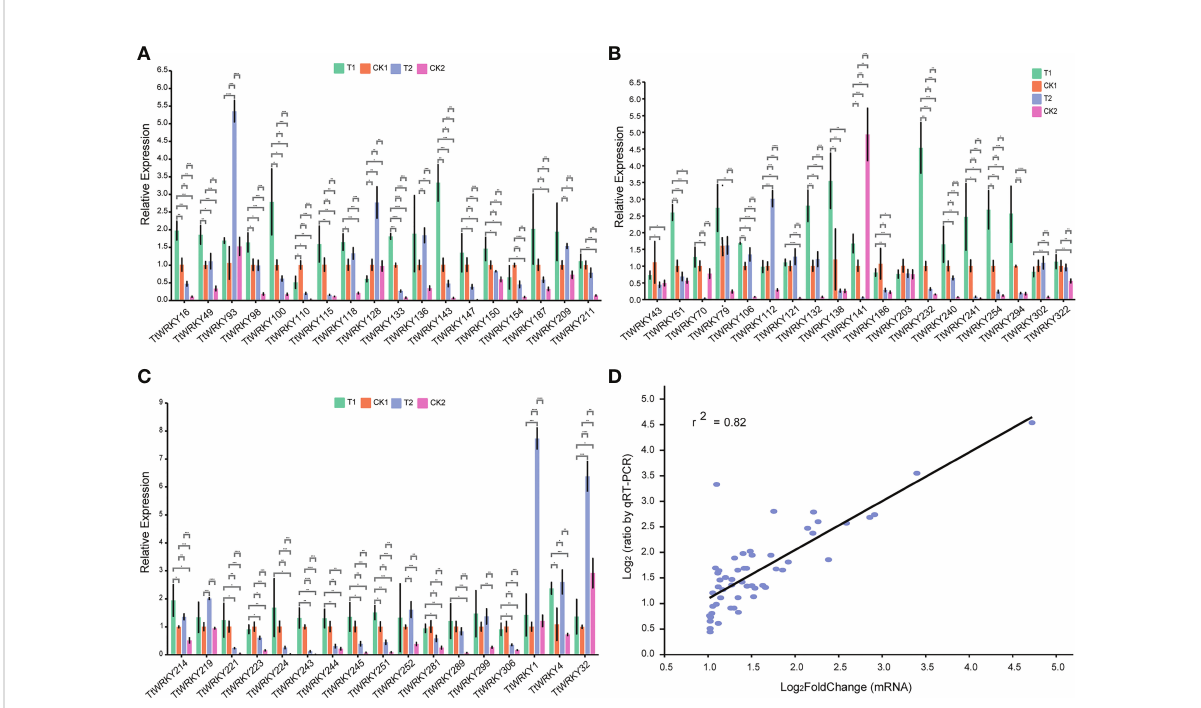
FIGURE 6 (A – C) Expression analysis of 54 WRKY genes in eleven samples by qPCR. Data were normalized to b -actin gene and vertical bars indicate standard deviation. (D) The relationships between qPCR and transcriptional of 54 up-regulated expression genes. Values are the log 2 ratio (salt stress or recovery treatment/CK treatment) for genes. The determine coef fi cient (r 2 ) is indicated in the fi gure. All qPCR reactions were performed in three biological replicates. Asterisk, double and triple asterisks indicate signi fi cant differences (p < 0.05, 0.01 and 0.001, respectively) between